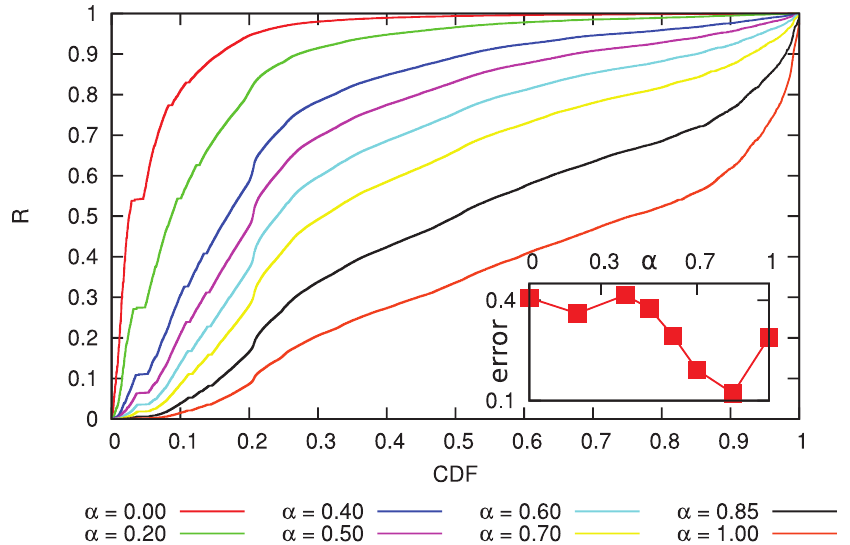
Figure 11. Rank function for the growth of balances. The cumulative distribution function of the R values (see Eq. 5) for exponents 0 , 0 : 2 , 0 : 4 , 0 : 5 , 0 : 6 , 0 : 7 , 0 : 85 and 1 . The inset shows the maximum Kolmogorov-Smirnoff error for these exponents. Here, the results are not as obvious as in the case of link creation (Fig. 7; a simple power-law form like in Eq. 4 is not sufficient to accurately model the statistics of money flow. On the other hand, the ‘‘average’’ behavior shows a correlation between the balance and the increase of the balance: the uncorrelated assumption ( a ~ 0 ) clearly gives a much worse approximate than the exponents that presume preferential attachment ( a w 0 ).